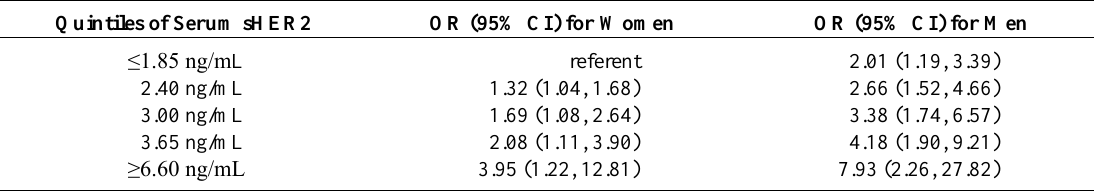
Table 5. Age-adjusted relative risk of adenocarcinoma associated with serum sHER2 concentration. Age-adjusted odds ratios (OR) and 95% confidence intervals (95% CI) comparing healthy men and women ( i.e ., controls) vs. patients with adenocarcinoma are shown for quintiles of serum sHER2 concentration by